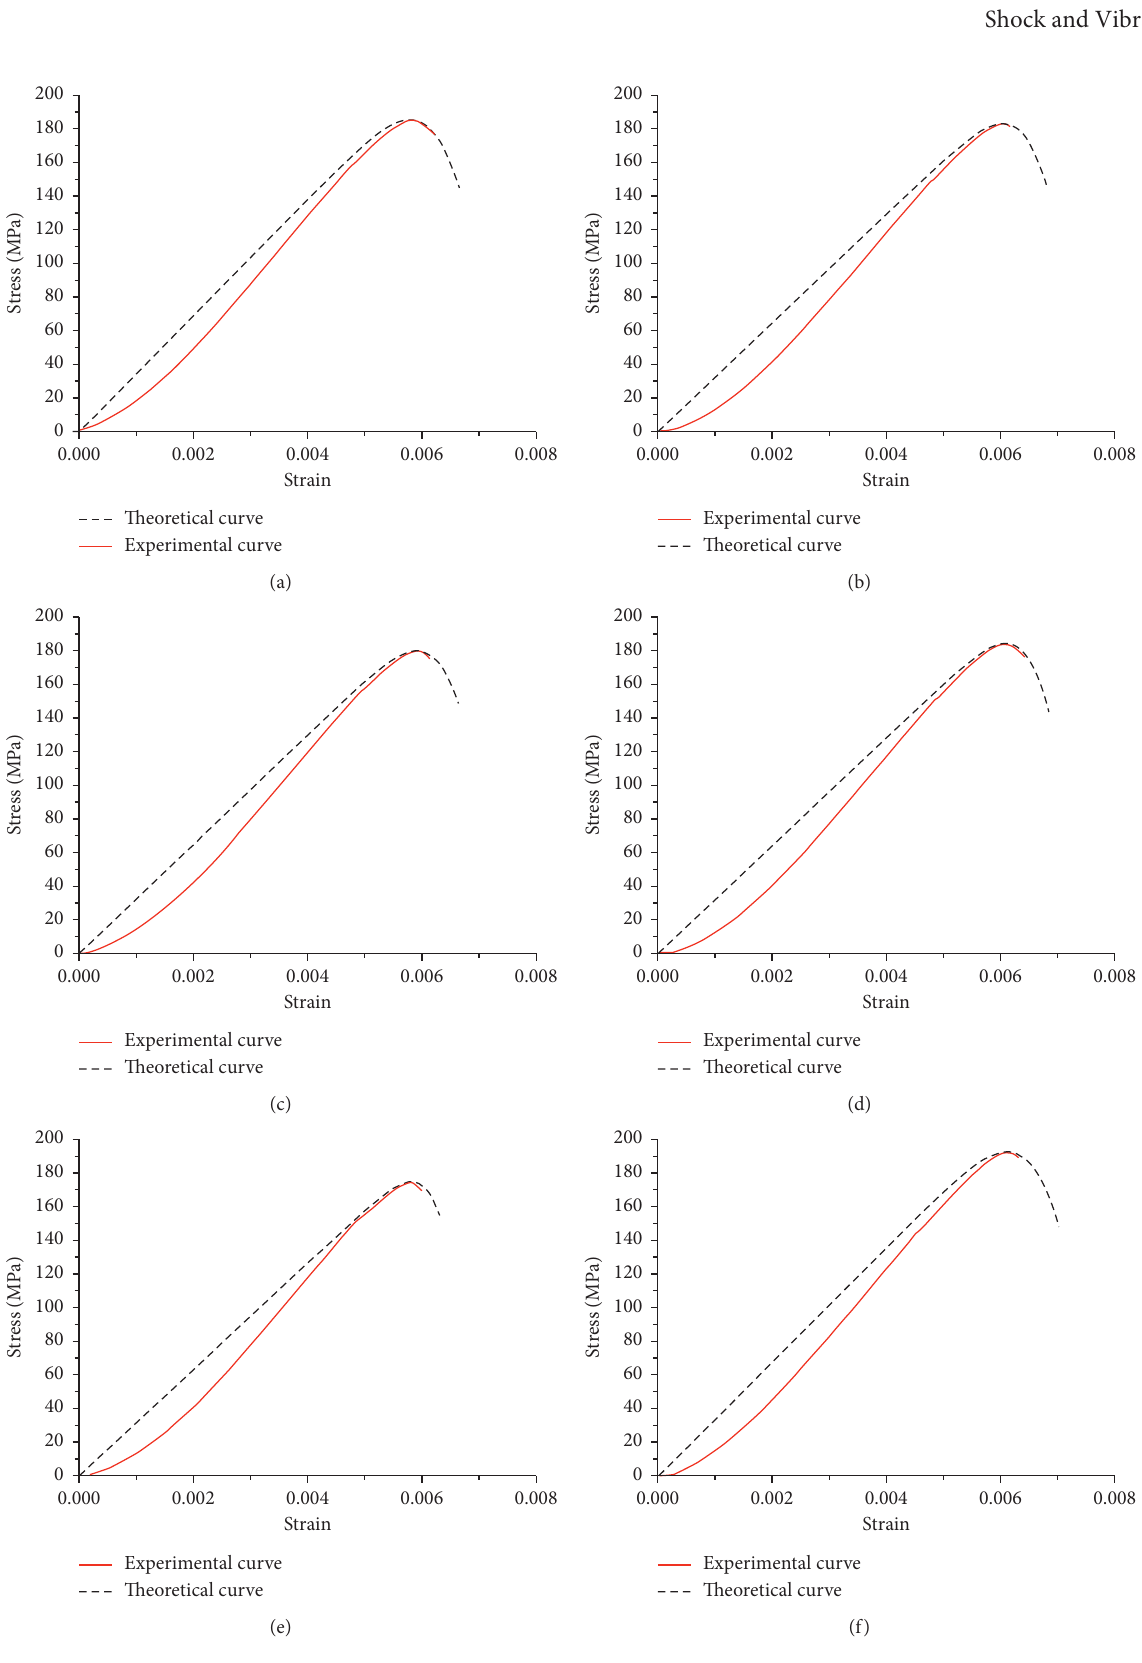
Figure 13: Comparisons between theoretical and experimental curves for granite